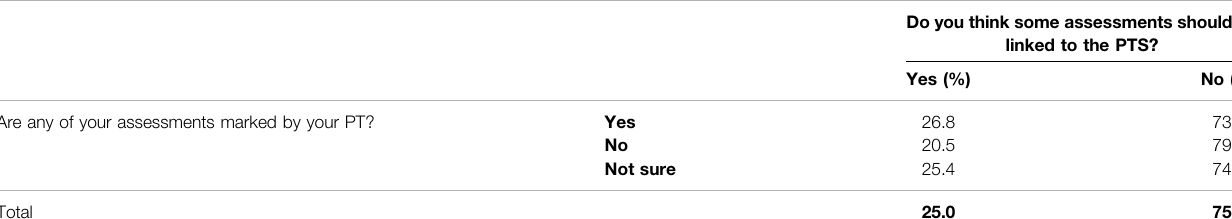
Do you think some assessments should be linked to the PTS? Yes (%) No (%)